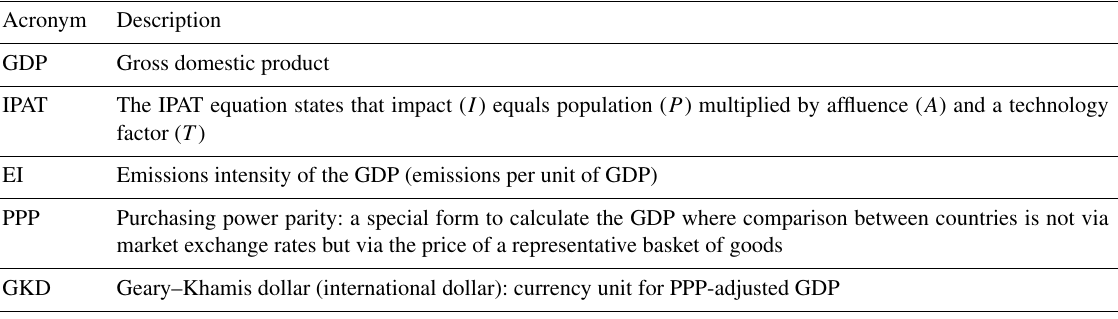
Table A5. Economical acronyms.